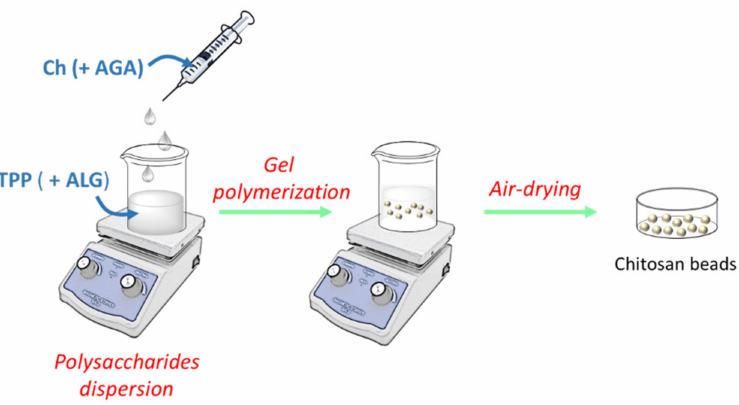
Figure 2. General flow chart of the preparation of chitosan-based